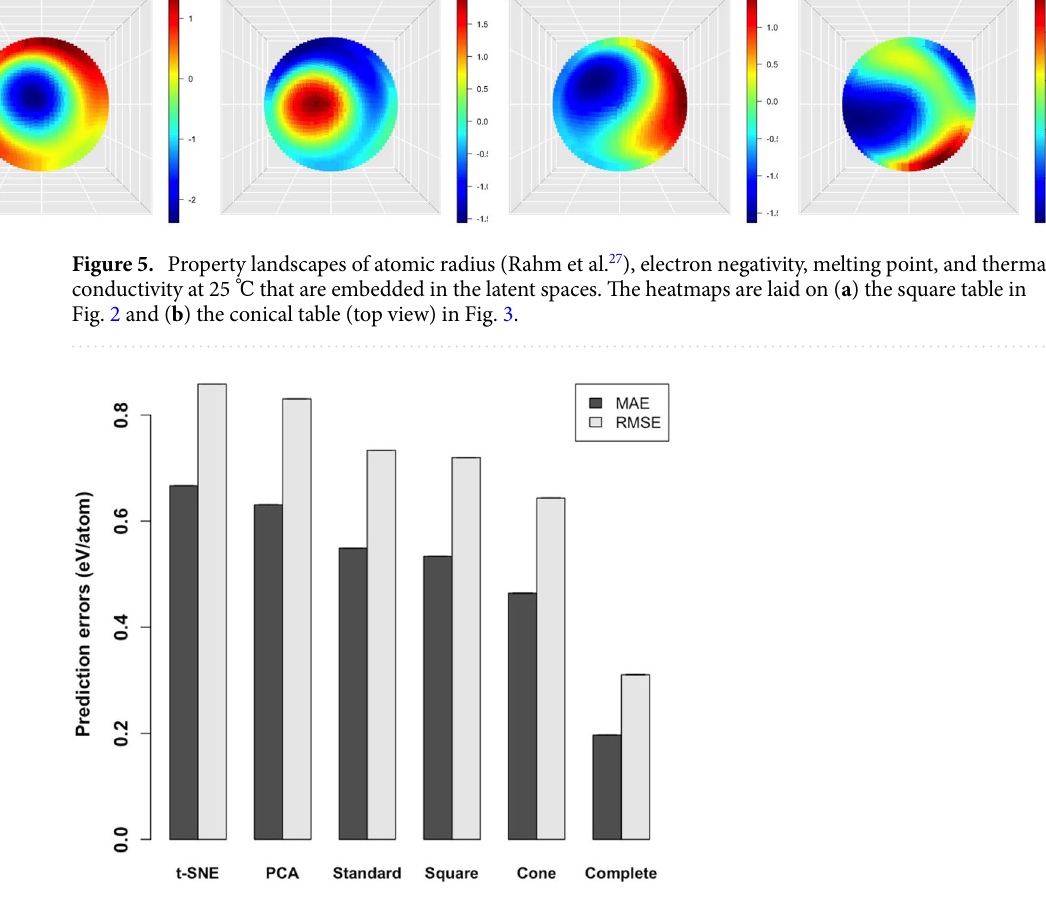
Figure 6. Performance of the prediction of the formation energy per atom for the models using six different descriptors. The vertical axis indicates cross-validated MAE and RMSE of RF regressors trained with the six different descriptors obtained from the coordinates of elements in the representation made by t-SNE and PCA (corresponding to top-left and top-right in Fig. S3, respectively), the standard periodic table, the square PTG table, the conical PTG table, and the complete set of the 39-dimensional feature that were used to build the PTG table, respectively. The error bars denote the standard deviations in five independent trials of the cross- validation (the error bars are invisible because of substantially small